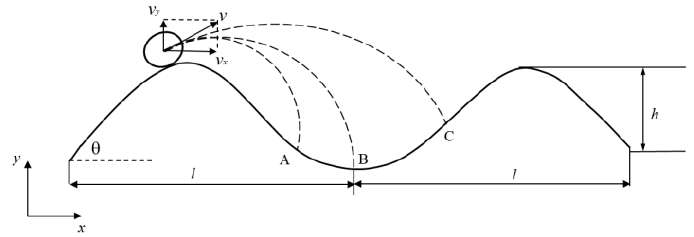
Figure 8. Throwing trajectory of BSF sand mixture on curved screen.